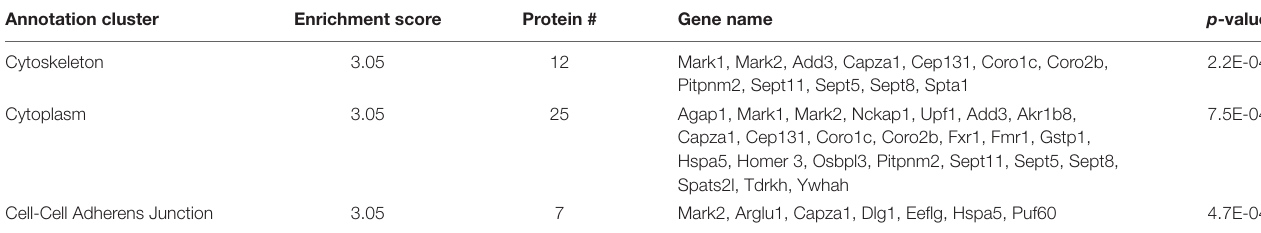
FIGURE 2 | Log 2 fold change of SIPs between SERT Ala56 and WT SERT. Log 2 fold change of (A) precursor ion intensity and (B) normalized spectral counts. Proteins in red indicated proteins increased interaction with SERT Ala56 compared to WT and blue labeled proteins show decreased association with SERT Ala56 compared to WT SERT based on precursor ion intensity. TABLE 1 | DAVID functional analysis of SIPs increased with SERT